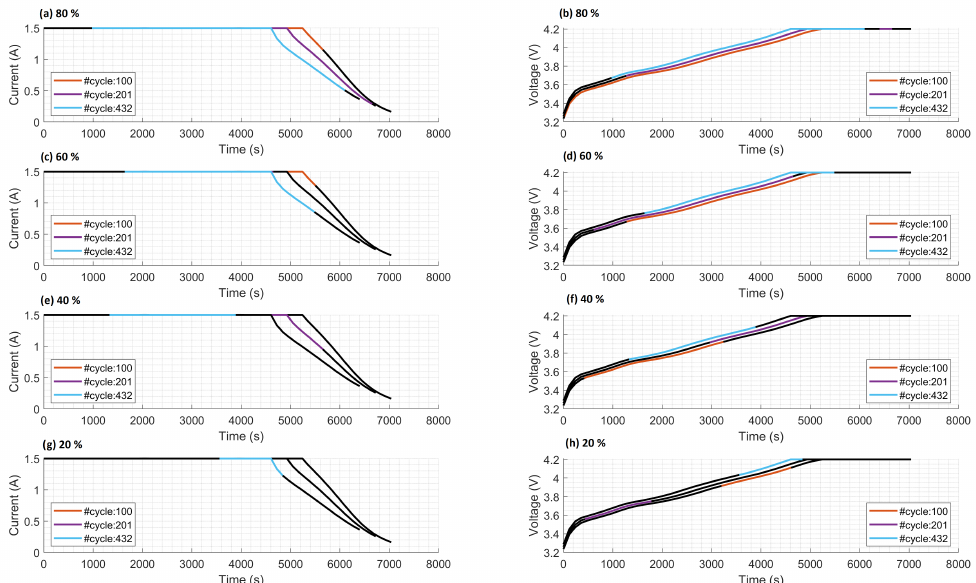
Figure 5. Operating current and voltage of few partial charging segments. ( a , b ) are operating current and voltage of the partial charging length equal to 80%. ( c , d ) are operating current and voltage of the partial charging length equal to 60%. ( e , f ) are operating current and voltage of the partial charging length equal to 40%. ( g , h ) are operating current and voltage of the partial charging length equal to 20%. In the graphs, the black lines is the full size of data (equal to 100% of